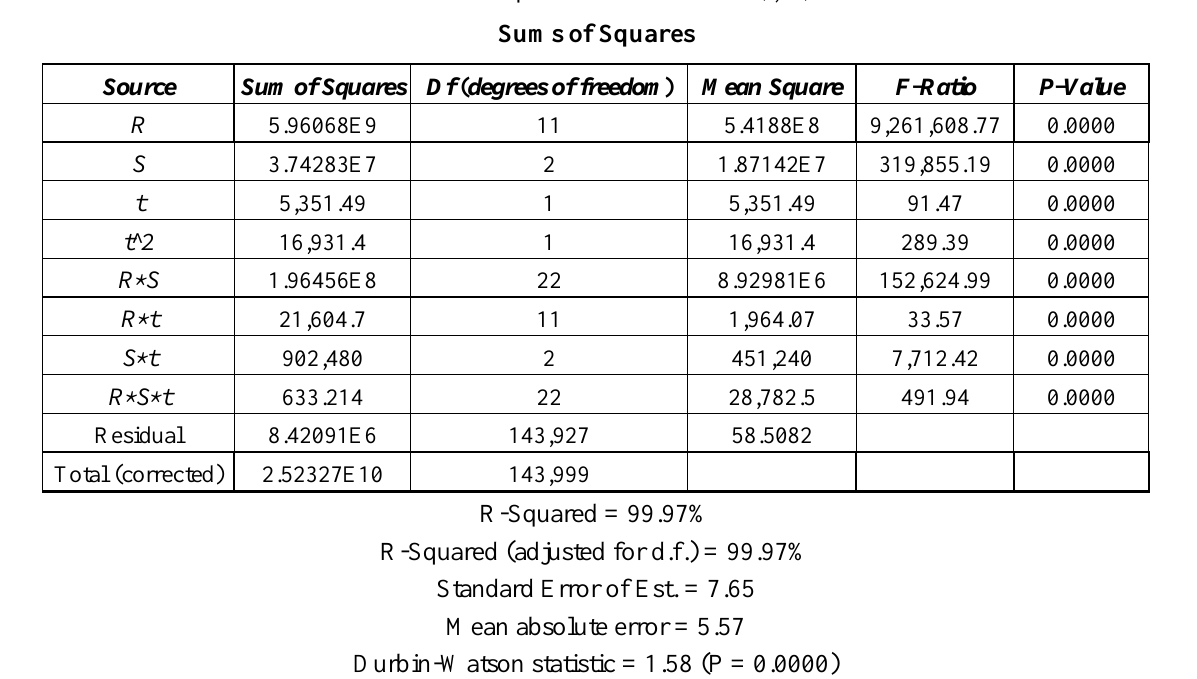
Table 3. ANOVA table after adjusting the radiometric response function model. All the effects are statistically significant (P-Value). The standard error results 7.65 raw units. The mean absolute error results 5.57 raw units. The goodness-of-fit is